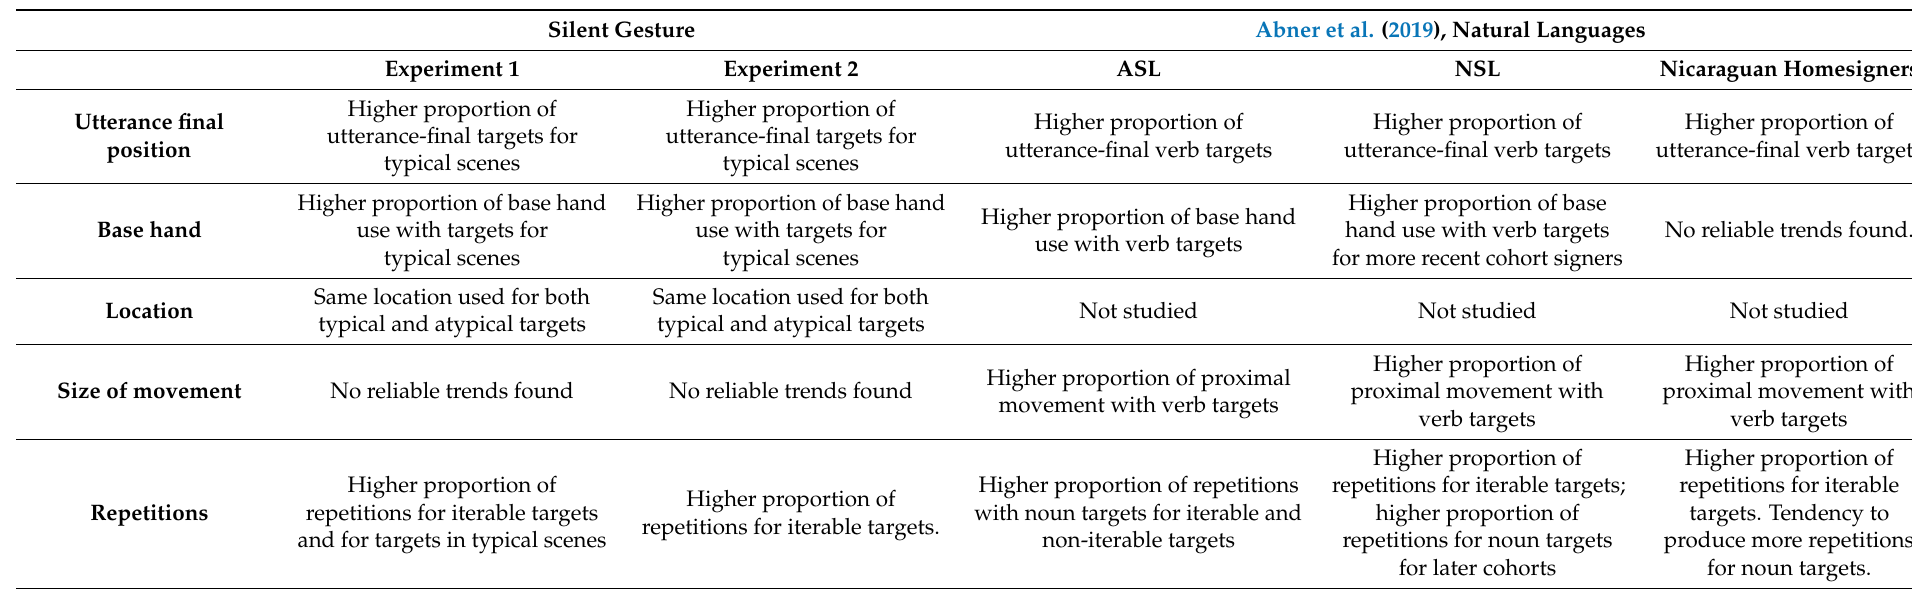
Table 1. Summary of findings from current studies and those reported by Abner et al. (2019) for ASL, NSL and Nicaraguan